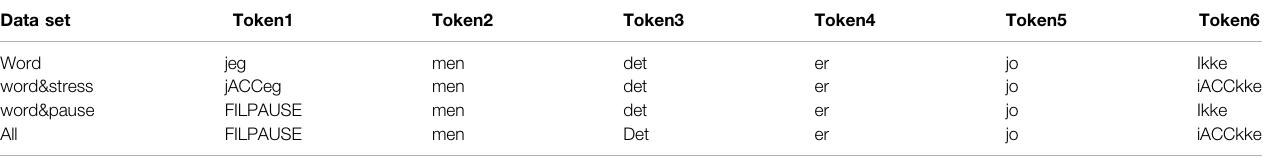
TABLE 4 | Examples of various data sets. Data set